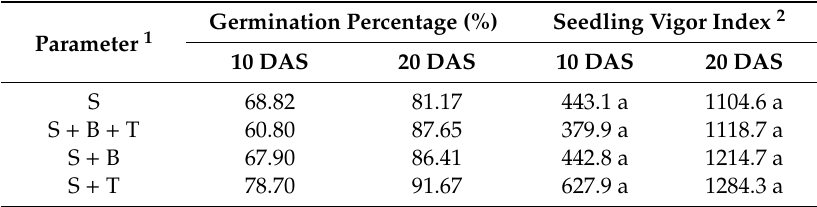
Table 2. E ff ect of inoculations on the germination and seedling vigor index.